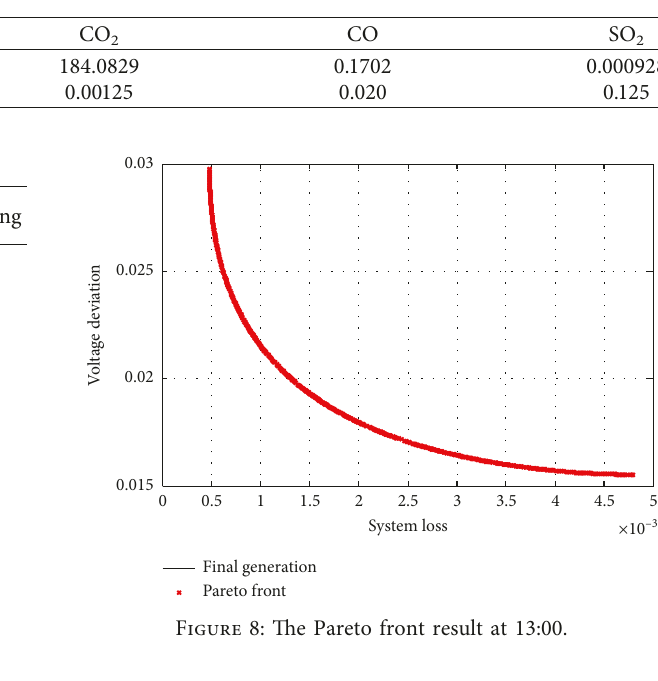
Table 8: Pollutant emission of the MT.